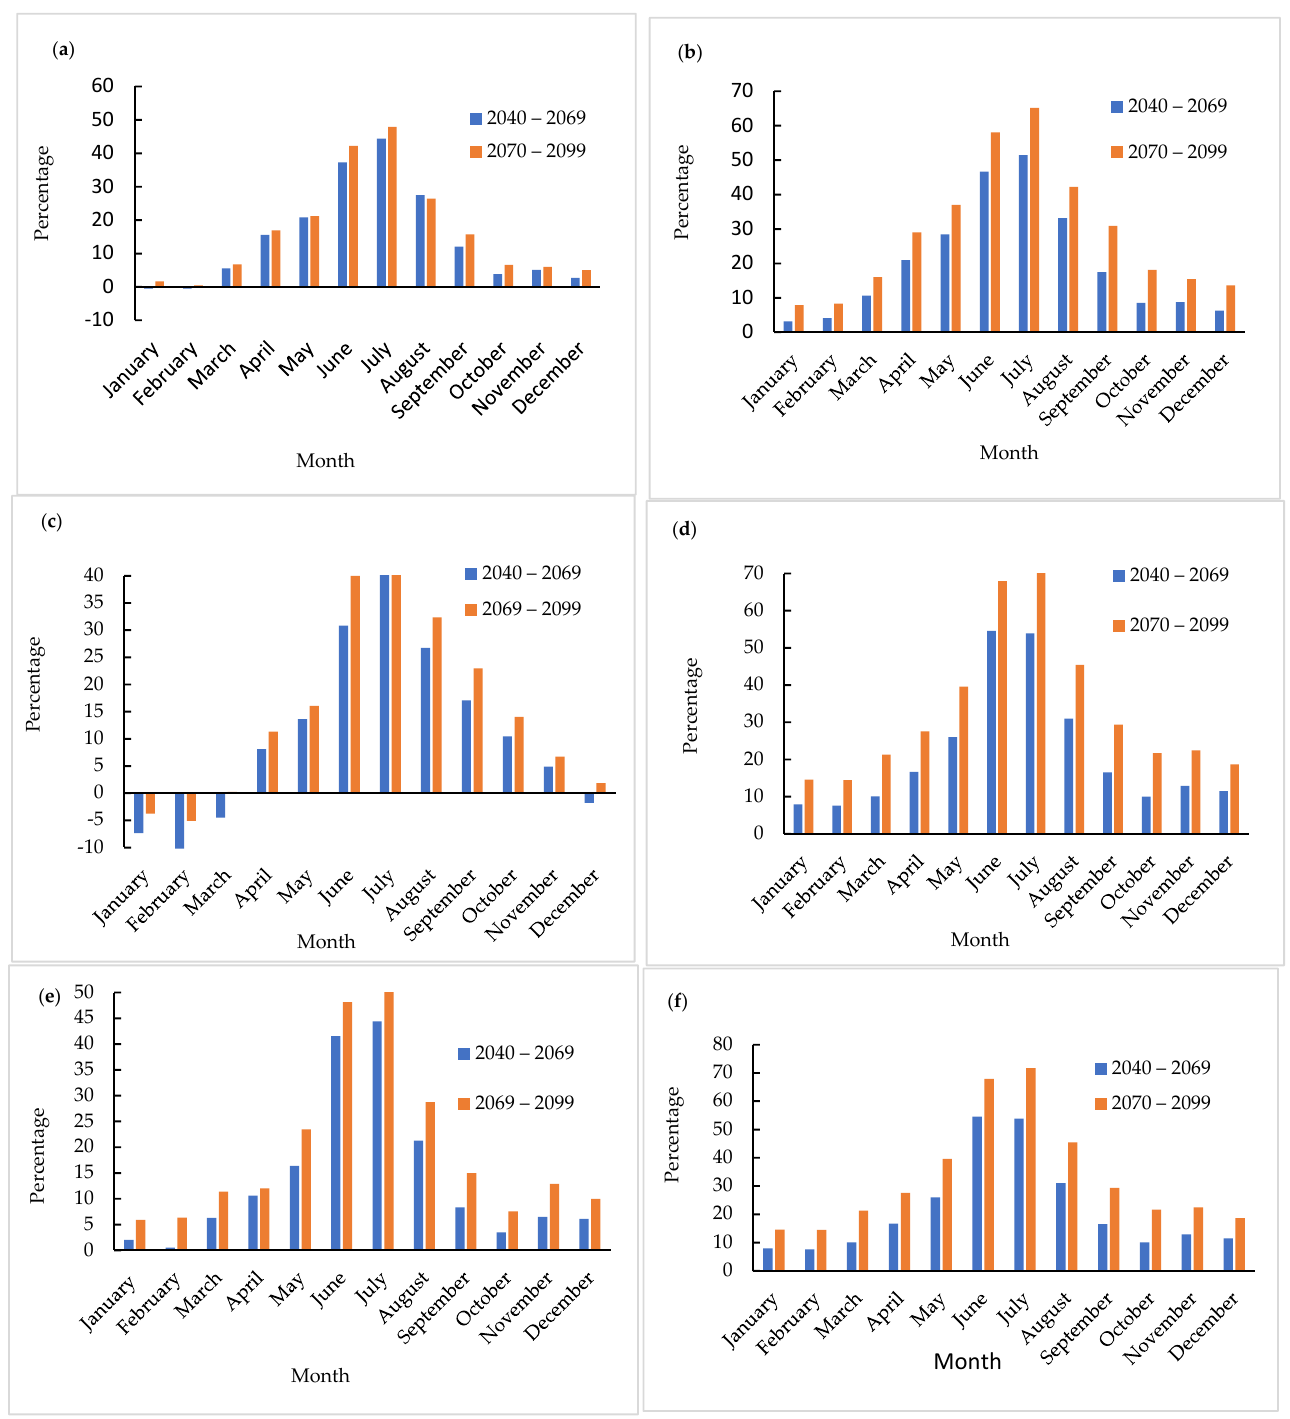
Figure 3. Percentage variations from the baseline of average monthly temperatures for the two thirty-year future periods for all three GCMs under the two RCPs, ( a ) BCC RCP 4.5, ( b ) BCC RCP 8.5, ( c ) GFDL RCP 4.5, ( d ) GFDL RCP 8.5, ( e ) MIROC RCP 4.5 and ( f ) MIROC RCP